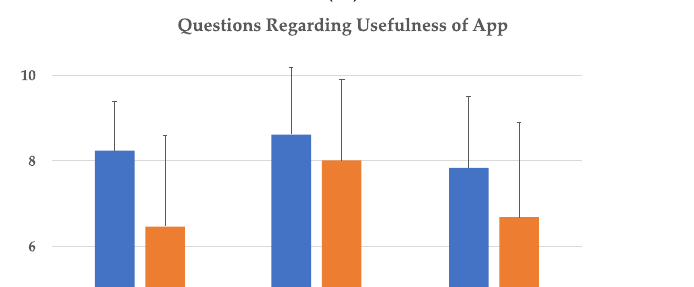
Figure 6. Physical activity data. * p < 0.05 by intragroup analysis.